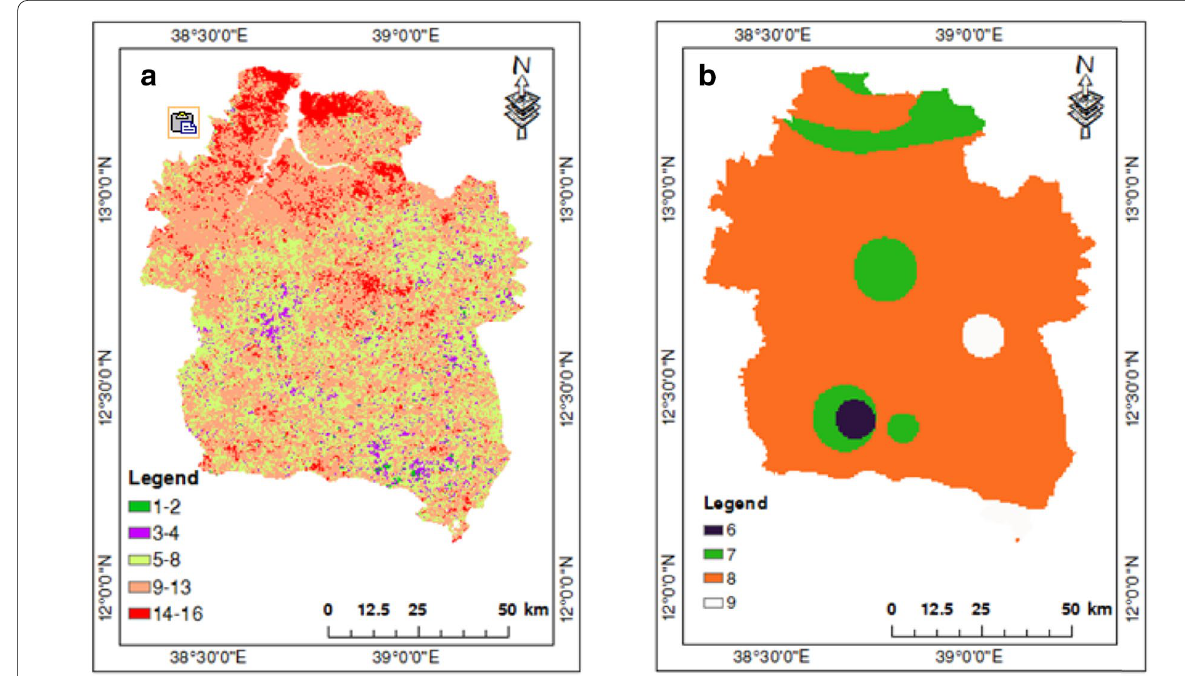
Fig. 17 Frequency of agricultural ( a ) and metrological ( b ) drought risk map